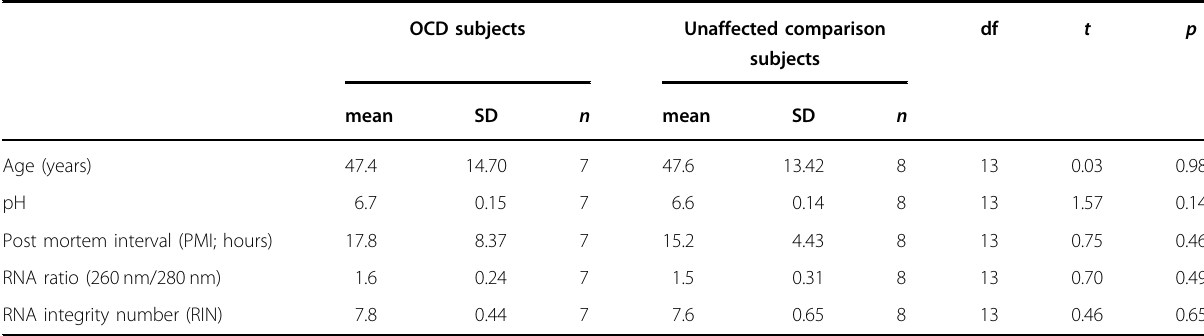
Table 1 Cohort demographics.